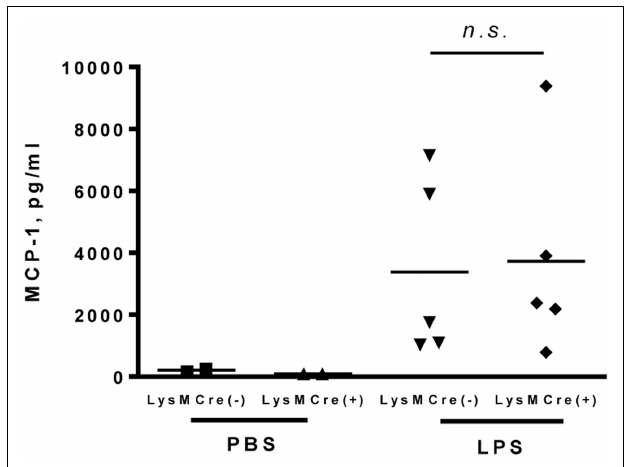
FIGURE 4 | MCP-1-deficiency in myeloid cells does not alter the production of MCP-1 in response to LPS in air pouches . Each mouse was given an injection with 1ml PBS or PBS containing 1mg LPS into the air pouch. Four hours after injection, air pouches were flushed with 2ml PBS with heparin.The concentration of MCP-1 in the air pouch fluids was measured by ELISA. Data is presented as the mean ± SD.